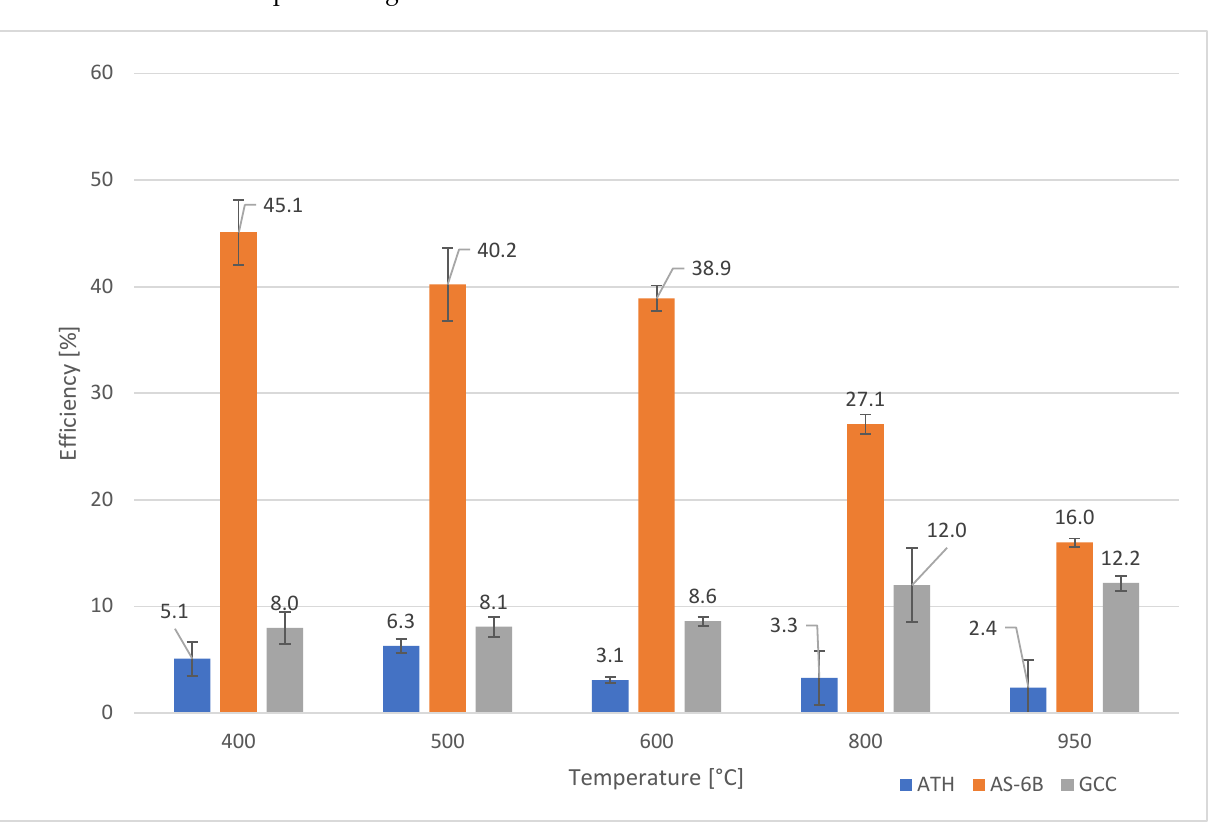
Figure 1. Efficiency % (T) of F50.5 (Orange), F50.0 (Gray), and F50.2 (Blue). Standard deviation ranges are reported. ATH stands for Al(OH) 3 .